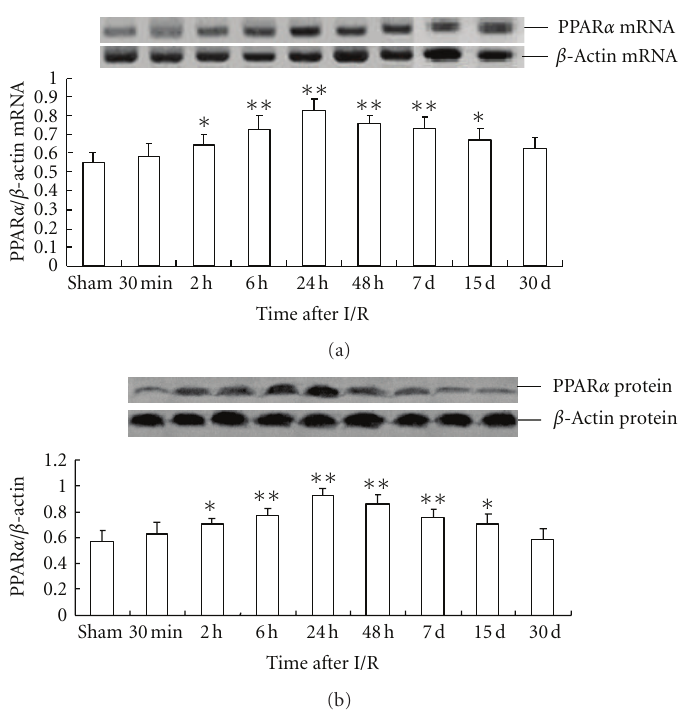
Figure 4: Time-dependent expression of PPAR α in global cerebral I/R rat hippocampus ( n = 4). (a) The relative mRNA level of PPAR α was normalized to endogenous β -actin mRNA for each sample. (b) The relative protein level of PPAR α was normalized to endogenous β - actin protein for each sample. Dates are expressed as mean ± SD of four individual experiments. ∗∗ P < 0 . 01 compared with sham group; ∗ P < 0 . 05 compared with sham